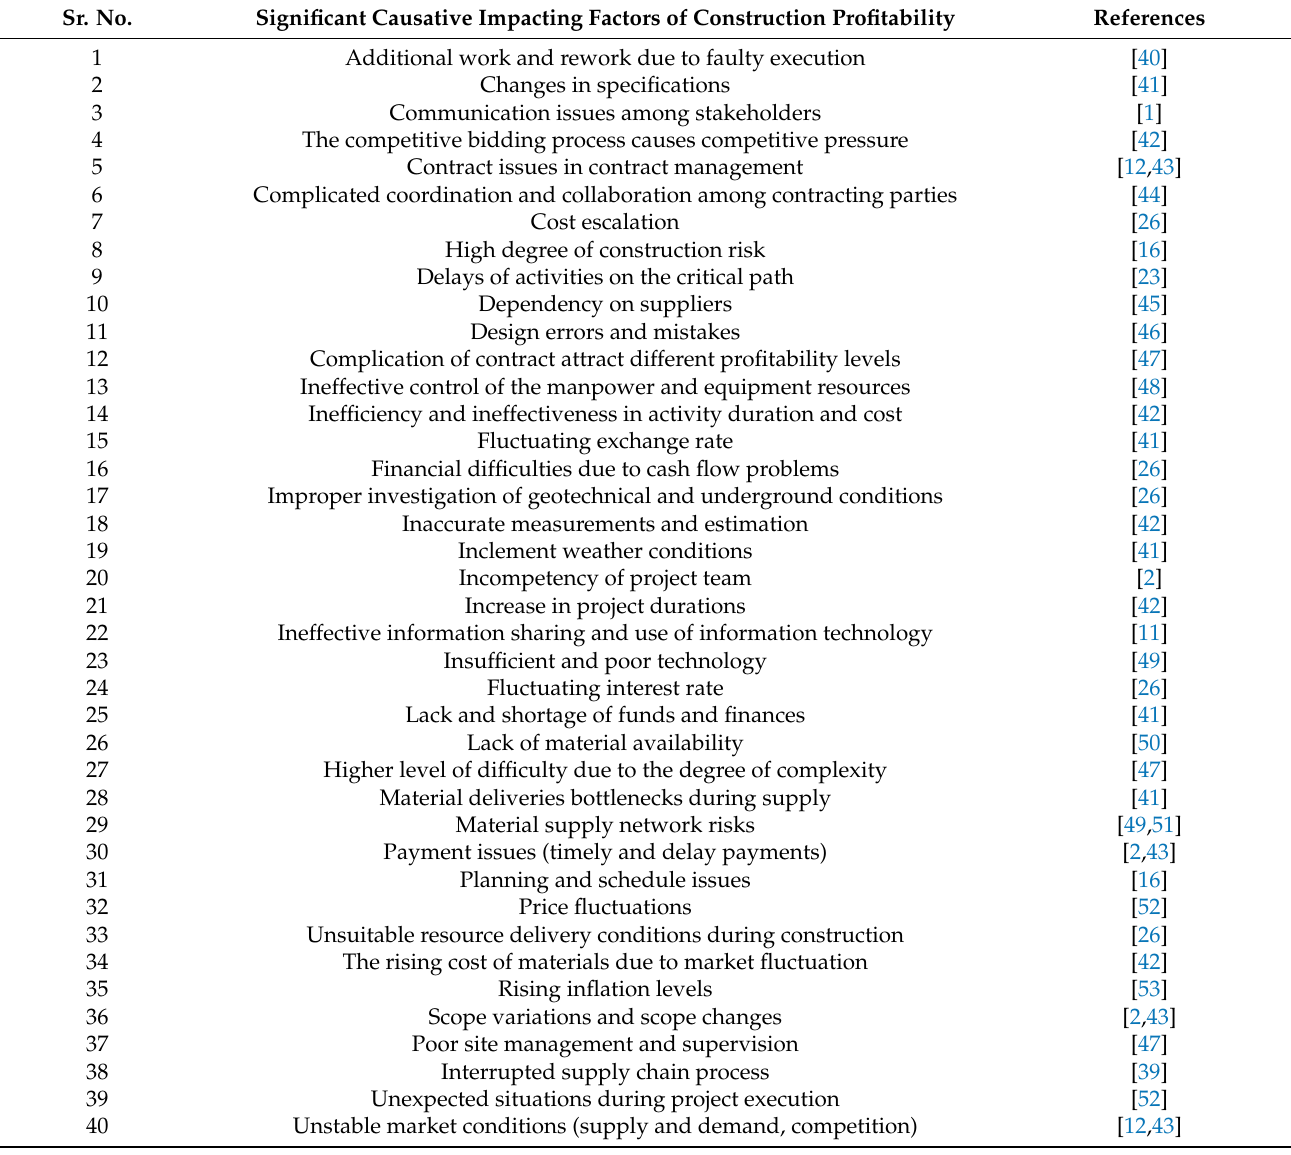
Table 1. Identification of profitability-influencing risk factors